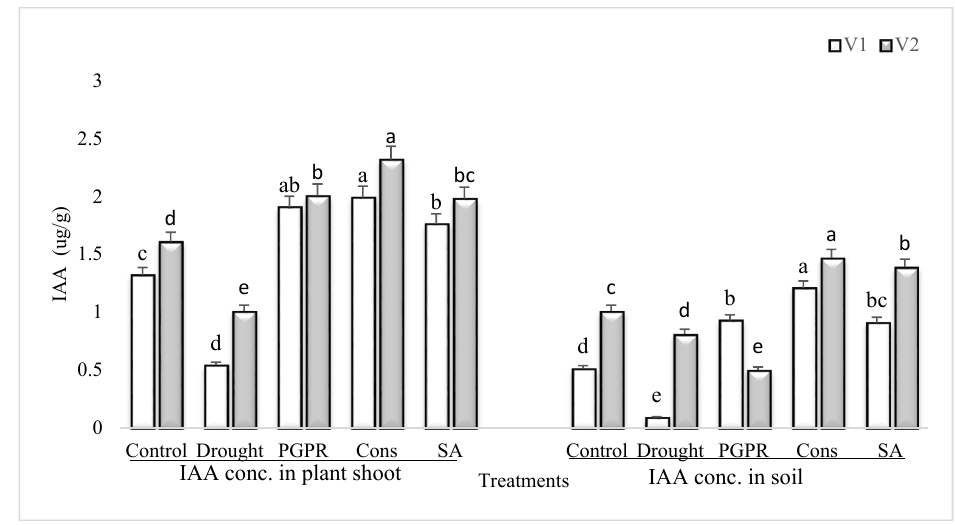
Figure 4. IAA content in plant shoot and rhizosphere of drought sensitive and tolerant varieties grown under rainfed conditions. V1: drought sensitive variety; V2: drought Tolerant variety. Di ff erent significance levels were denoted with di ff erent letters (a, b, c, d and